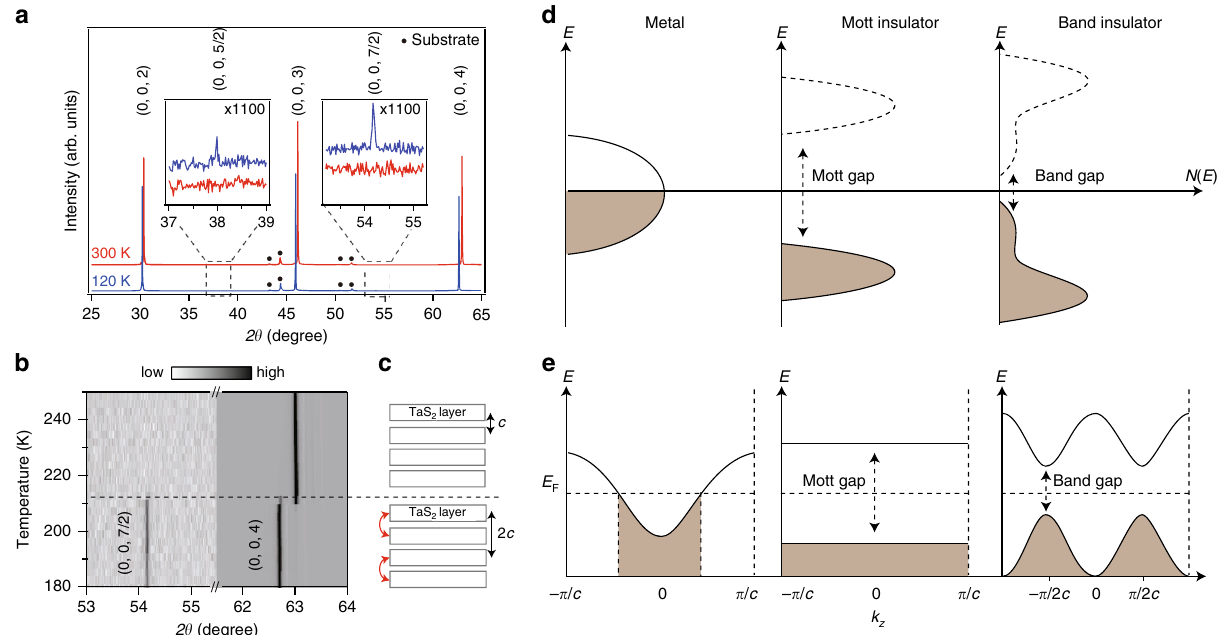
Fig. 5 Temperature-dependent XRD study and schematic depictions of band evolution. a XRD intensity of 1 T -TaS 2 measured along c axis at 120 and 300 K. Inset panels show the emergence of (0, 0, 5/2) and (0, 0, 7/2) peaks using 1100 times expanded scales. All the other peaks are from the polycrystalline substrate (Supplementary Fig. 4). b Temperature-dependence of the (0, 0, 7/2) and (0, 0, 4) peaks upon heating. c Schematic illustration of the interlayer dimerization. d Schematic illustration of the density of state distributions in different electronic phases. e Schematic illustration of the band dispersions along k z direction in different electronic